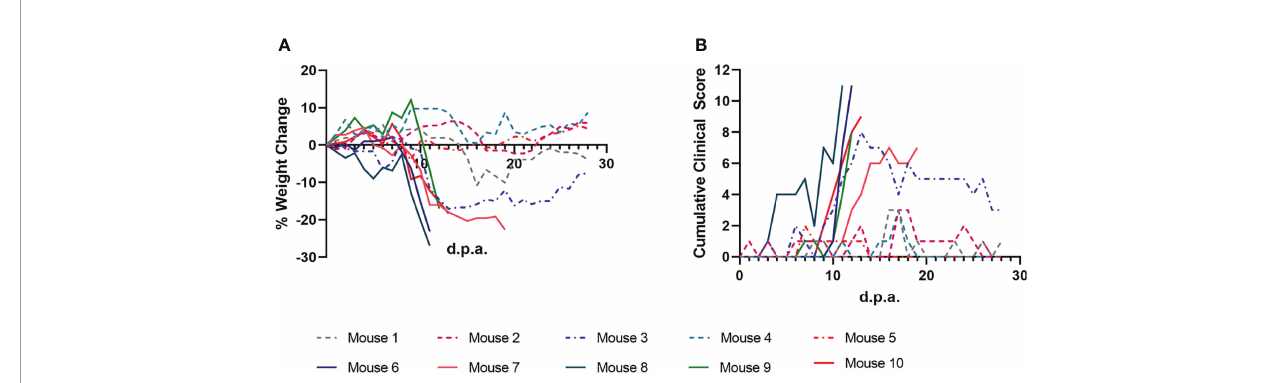
FIGURE 2 | Clinical markers of POWV disease progression in mice infested with POWV-infected H. longicornis . Mice 1 - 9 were each infested with an individual POWV II-injected adult female tick. Mouse 10 was infested with larvae (derived from the adult female tick fed on Mouse 6). (A) Percent weight change is represented as a line plot relative to the weight at study day 0. Weight loss greater than 20% was used as a humane endpoint for euthanasia. (B) Clinical disease scores are represented as a line plot with higher cumulative scores representing more severe disease. Cumulative clinical scores were assigned to each mouse daily based on weight loss, appearance, neurological signs of disease, and behavior. Lines that end before 28 days post-attachment (d.p.a.) indicate criteria for euthanasia were reached for a certain